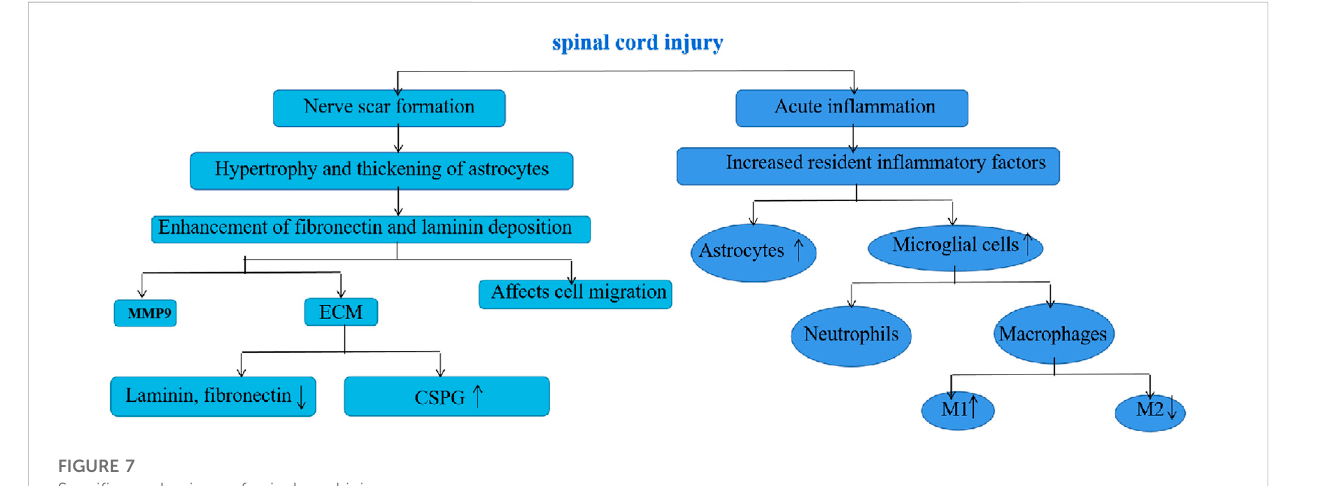
Speci fi c mechanisms of spinal cord